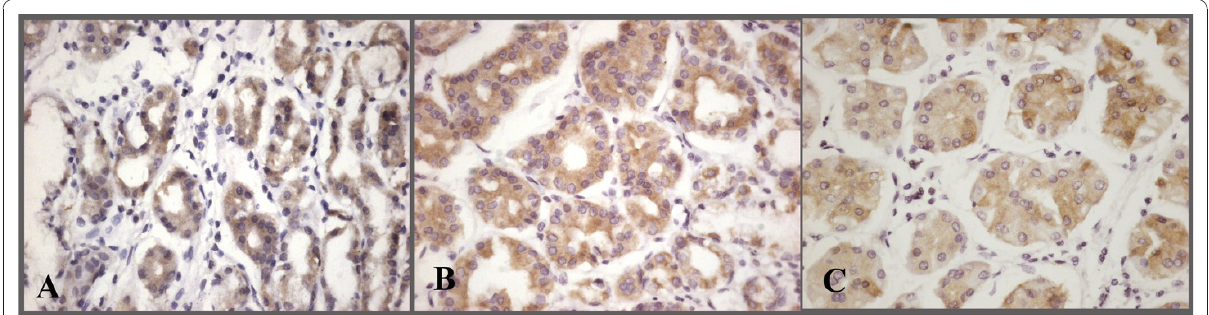
Figure 2 Plakophilin immunostaining in normal gastric glands . Homogeneous and strong cytoplasmic staining of PKP1(A), PKP2(B) and PKP3 (C)